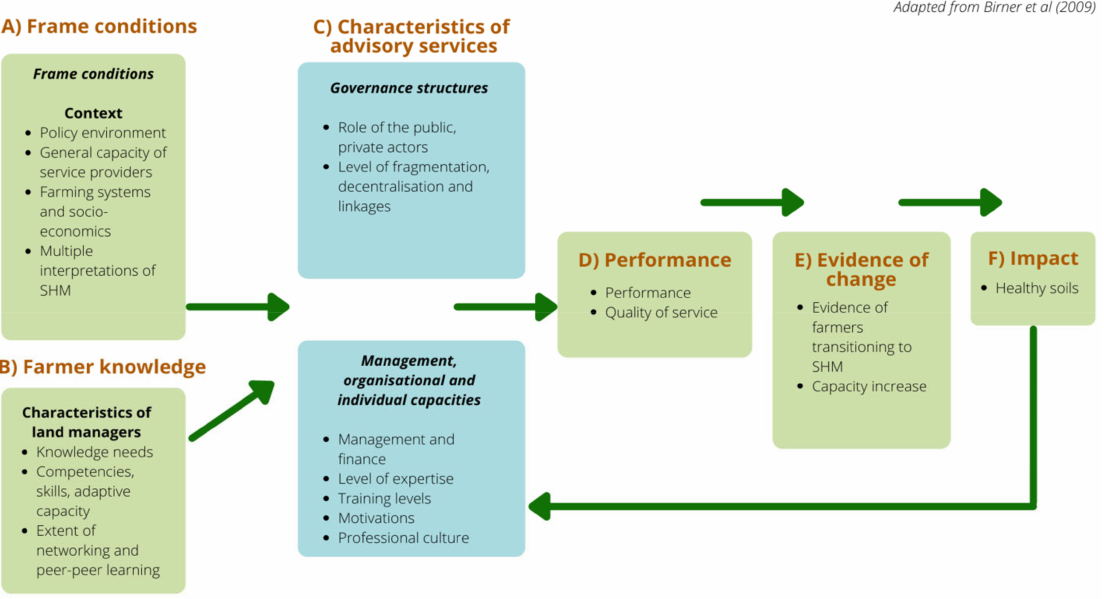
Figure 1. Framework—Blue shading represents the analytical characteristic investigated